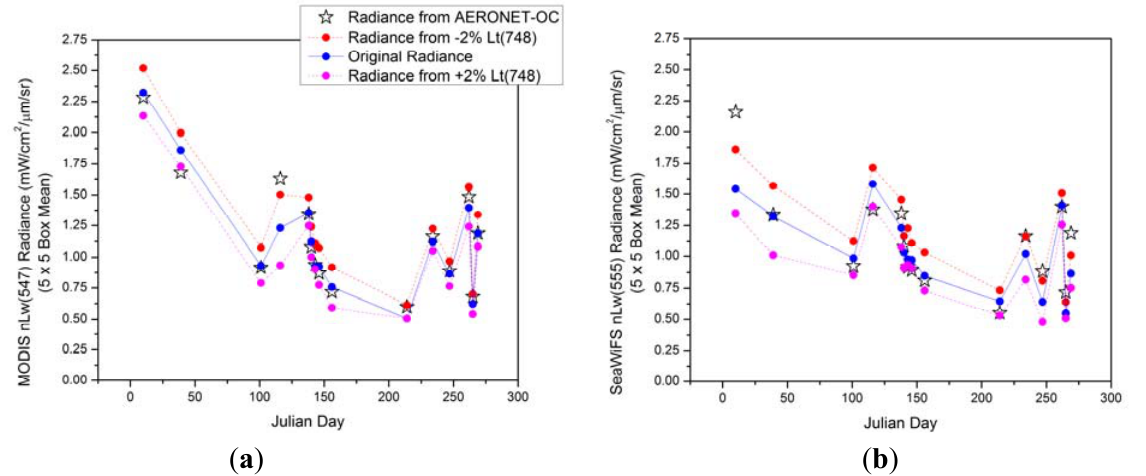
Figure 14. MODIS retrieved the Venice AERONET-OC site. ( a ) Original and adjusted (±2%) L ( b ) L (769) for SeaWiFS, with AERONET-OC t